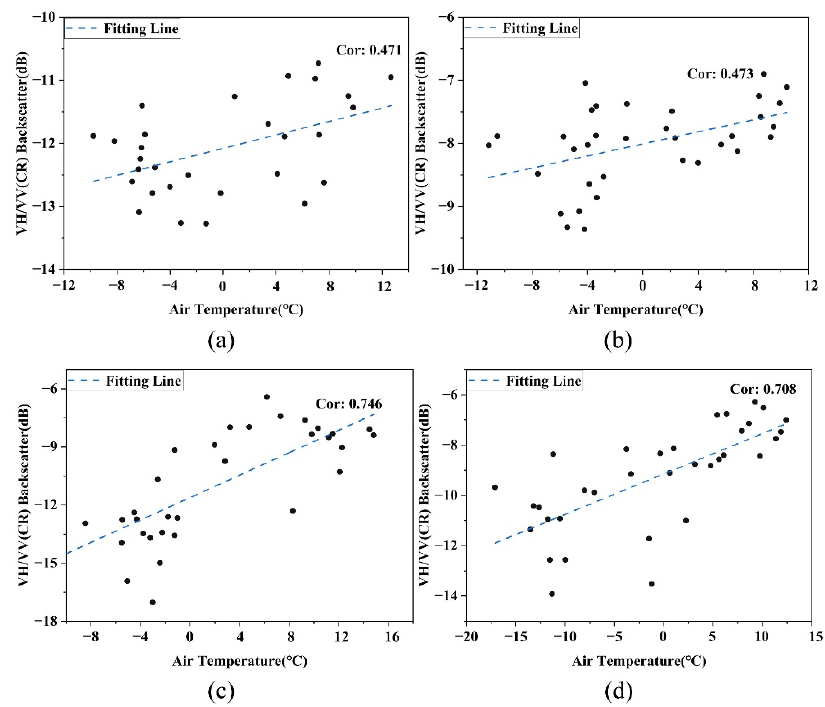
Figure 10. Pearson correlation coefficients between monthly scale air temperature (°C) and CR values (dB) for soil areas in the four study areas: ( a ) FV; ( b ) RS; ( c ) NK; ( d ) AP.